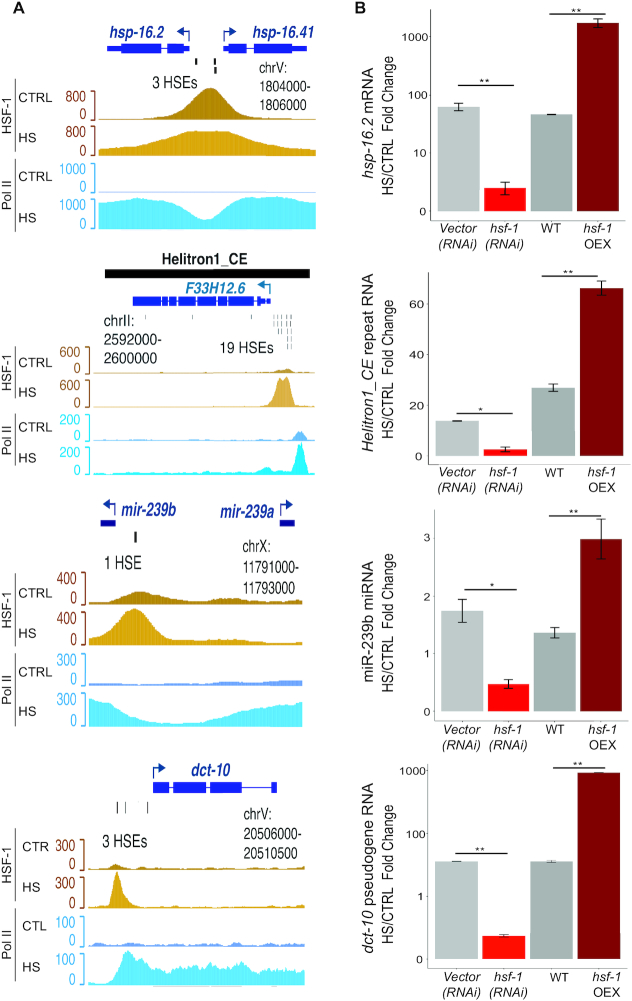
NcRNAs are regulated by HSF-1 during HS. (A) Genome browser screenshots of HSF-1 (yellow) and Pol II (blue) ChIP-seq data from control (CTRL) and HS conditions (data from (26)) for representative genes (hsp-16.2 and hsp-16.41, mRNA; Helitron1_CE, repeat RNA, miR-239a and miR-239b, miRNA; dct-10, pseudogene). Individual HSEs identified using FIMO (P < 1e-04) are indicated (30). (B) Fold change in RNA levels of hsp16.2, Helitron1_CE, miR-239b and dct-10 after 30 min of HS in animals subjected to empty vector or hsf-1 RNAi, and WT versus a strain overexpressing HSF-1 (hsf-1 OEX) determined by qRT-PCR analyses. The mean fold changes and SEM from three independent replicates are graphed. *P < 0.05, **P < 0.01 (t-test, two-sided).